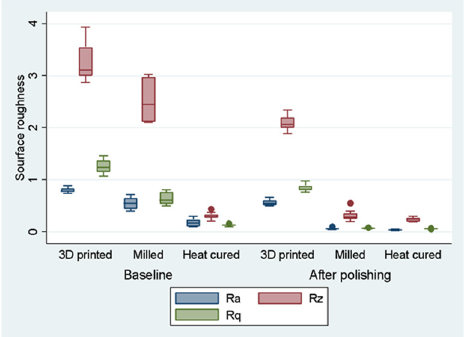
Figure 10. Box plot of surface roughness by resin before/after polishing. Notes: The distribution of rugosity coefficients for each of the three raisins (different colors), both before (baseline) and after polishing are displayed on the Y axis. A total of three measurements for surface rugosity were used: R a —arithmetical mean of the absolute values of the profile deviations from the mean line of the roughness; R z —average of all values that were represented by the maximum height between the maximum and the minimum profile within the assessment length; R q —the root mean square of the surface roughness.